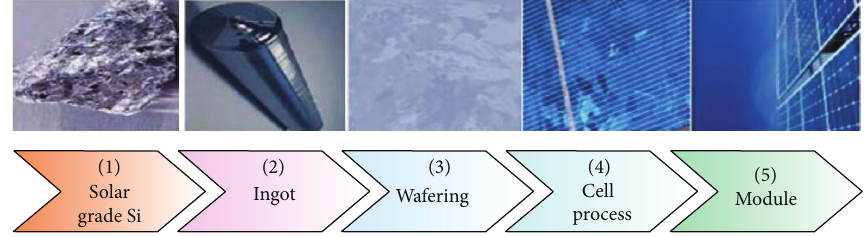
Figure 9: Crystalline Si cell standard chain: bulk of photovoltaics today